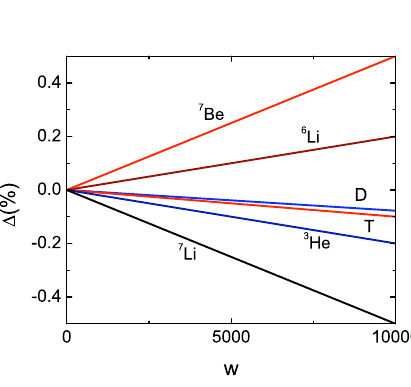
Figure 3: Variation (in percent) of the abundances of light nuclei produced in the BBN as a function of an artificial multiplicative factor w enhancing Salpeter’s formulation of screening [34].